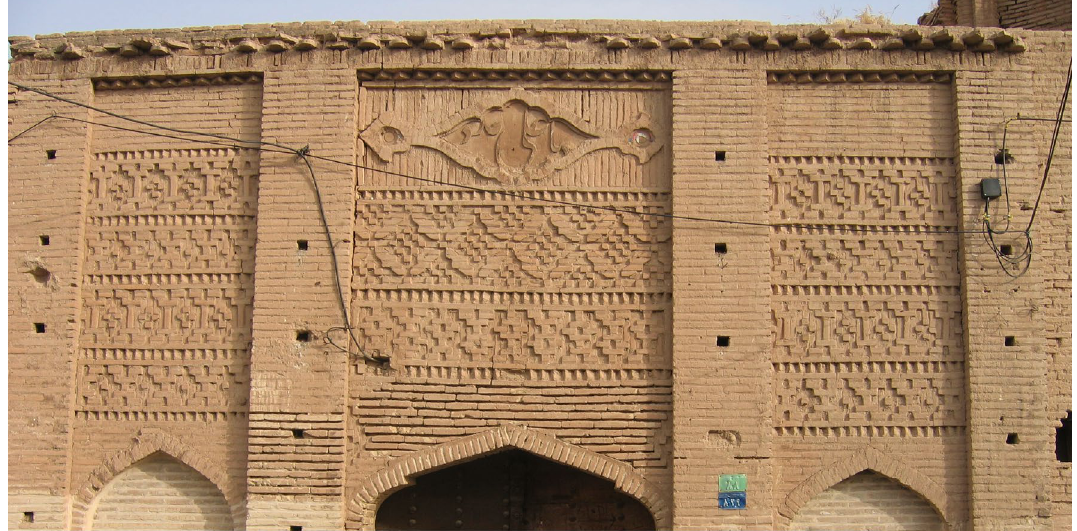
Fig. 9 Different shapes of Xowun in Mohseni Entrance house. Source: MCHT of